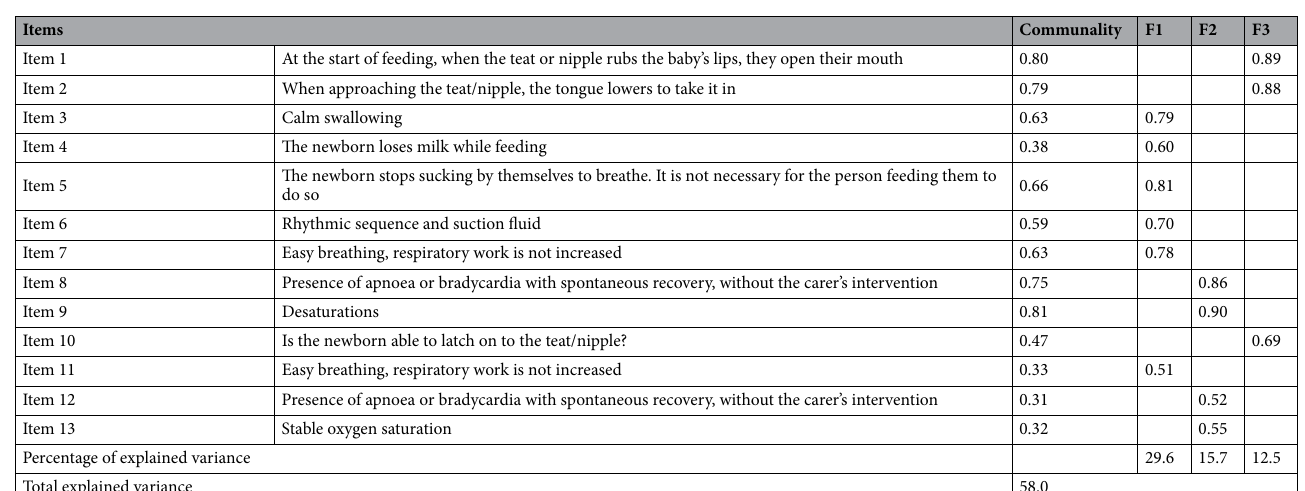
Table 2. Exploratory factor analysis of the OFEATINg scale with promax rotation structure matrix. F1: factor 1 capacity to coordinate sucking-swallowing-breathing; F2: factor 2 capacity to administer oxygen reserve; F3: factor 3 capacity to take the teat or